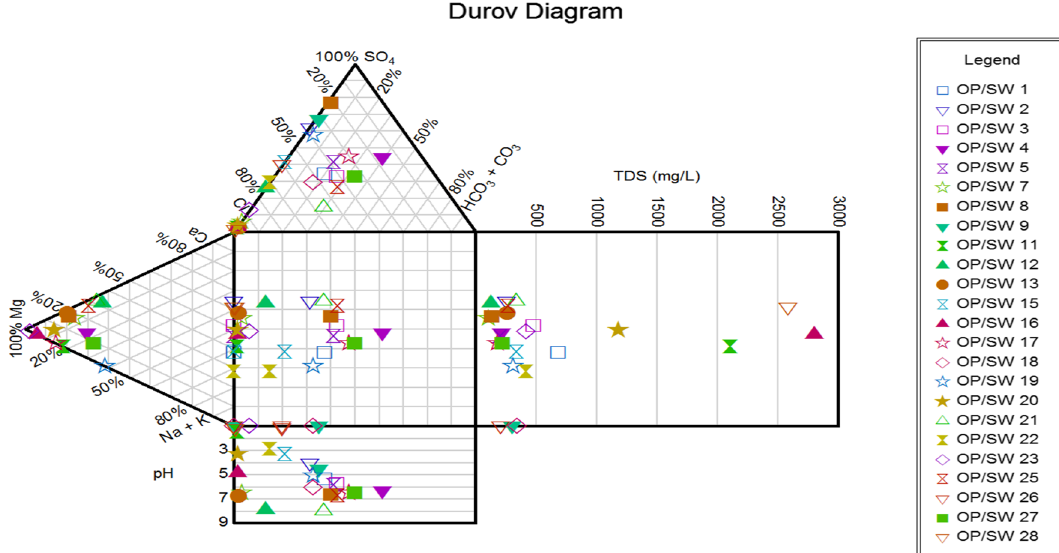
Fig. 8 Durov plot of surface water resources in the Enyigba area (after Hem 1991)